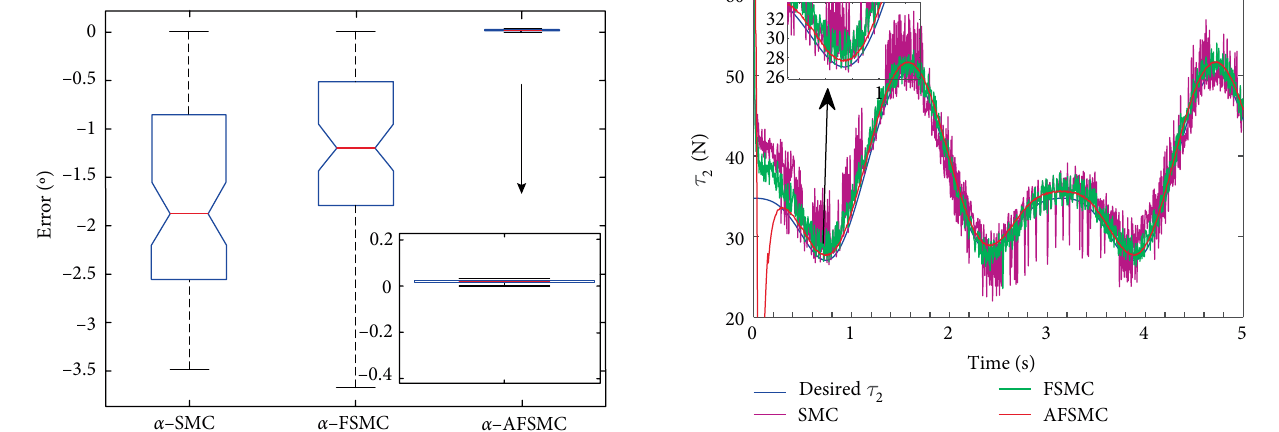
with three controllers. 𝑧